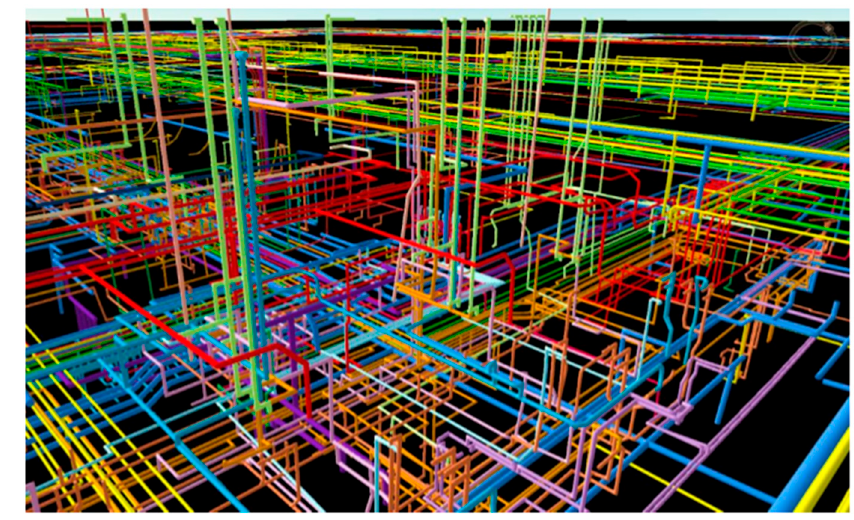
Figure 13. Pipeline network in the SuperMap iEarth.